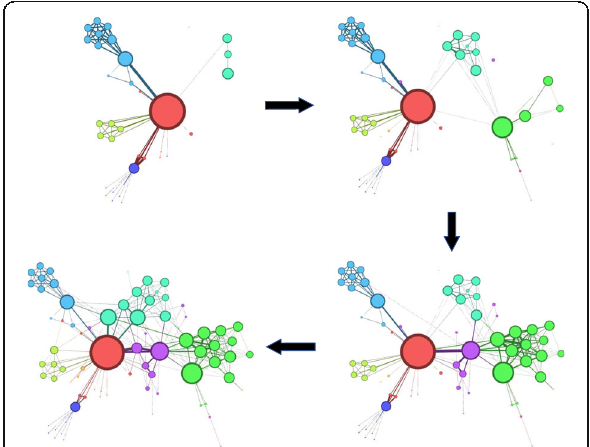
Fig. 3 The change of core subgraph from moment t to t +